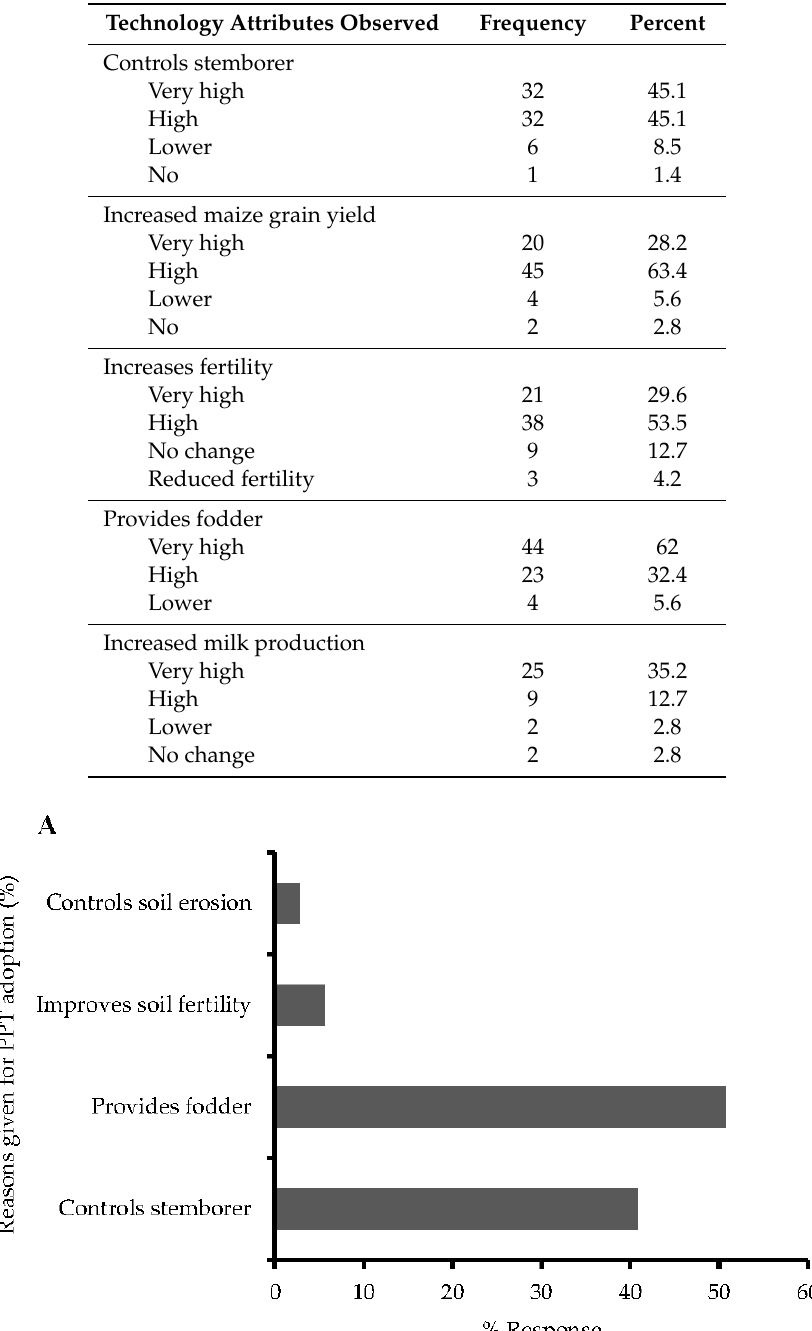
Table 4. Push-pull technology practicing farmer’s perceptions on PPT in the Hawassa district, Ethiopia. Technology Attributes Observed